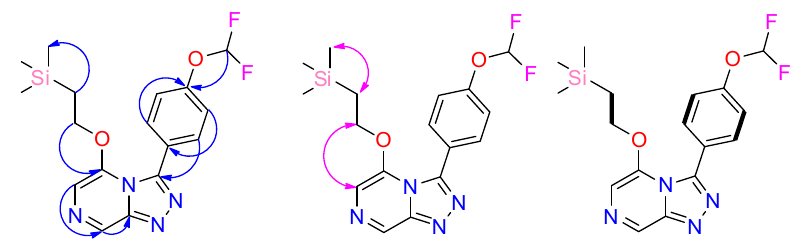
Figure 3. Key HMBC ( → ), ROESY ( ↔ ), and COSY ( — ) correlations for 5 .